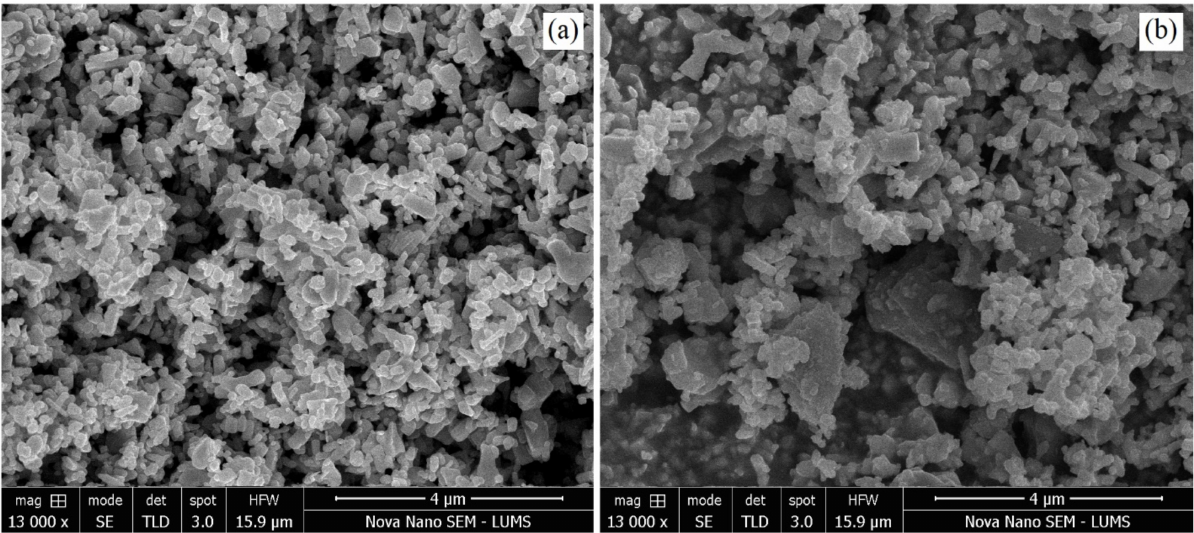
Figure 7. ( a ) SEM micrograph of run 4 (small-sized AgNPs), ( b ) SEM image of run 6 (large-sized